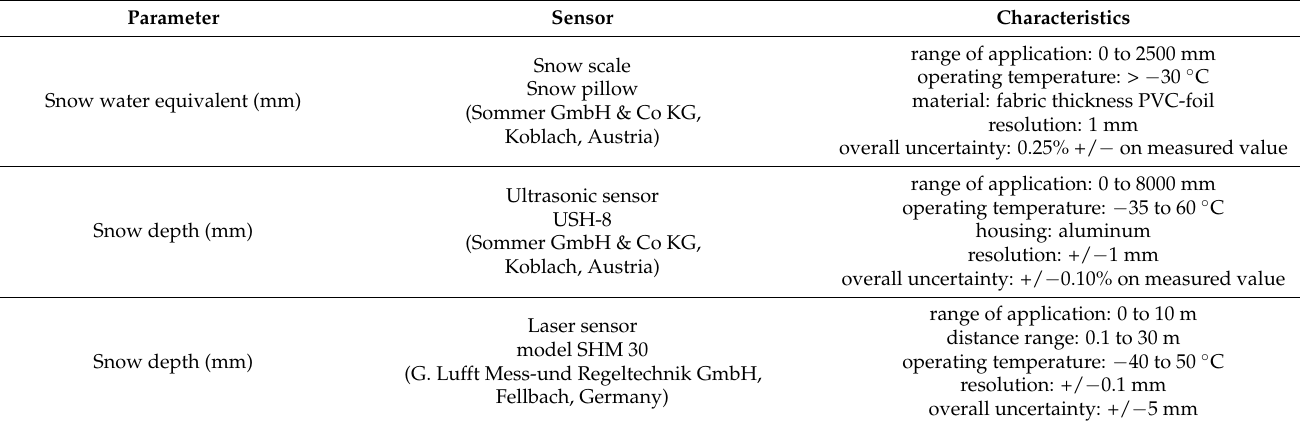
Table 2. Sommer GmbH & Co. KG snowpack station